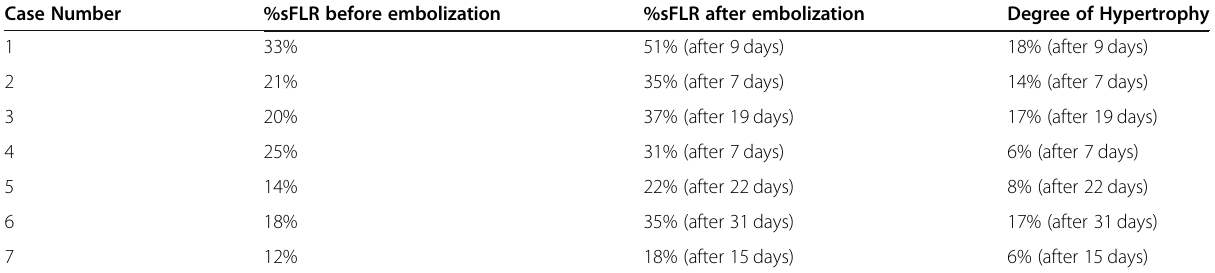
Table 3 Percentage of standardized future liver remnant (%sFLR) pre and post embolization as well as degree of hypertrophy Case